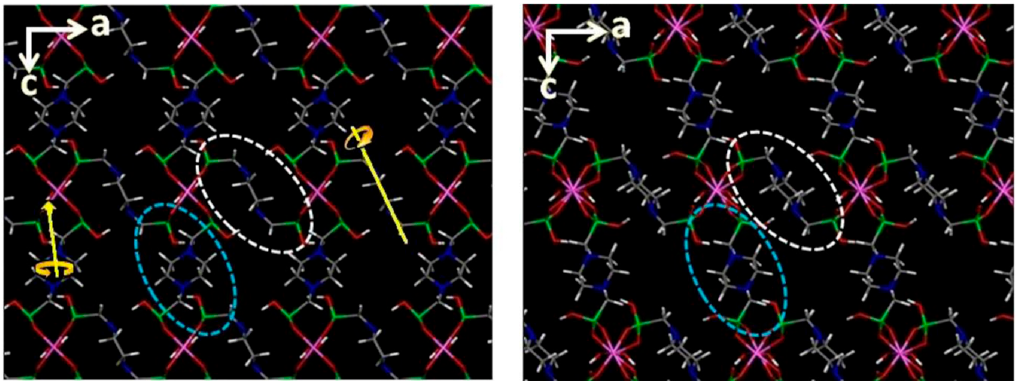
Figure 27. Crystal structure of MIL-91(Al) before ( left ) and after ( right ) the adsorption of CO 2 . The rotation of crystallographically independent linker units is highlighted within the white and blue circles. Reprinted with permission from reference. [69]. Copyright 2015, American Chemical Society.